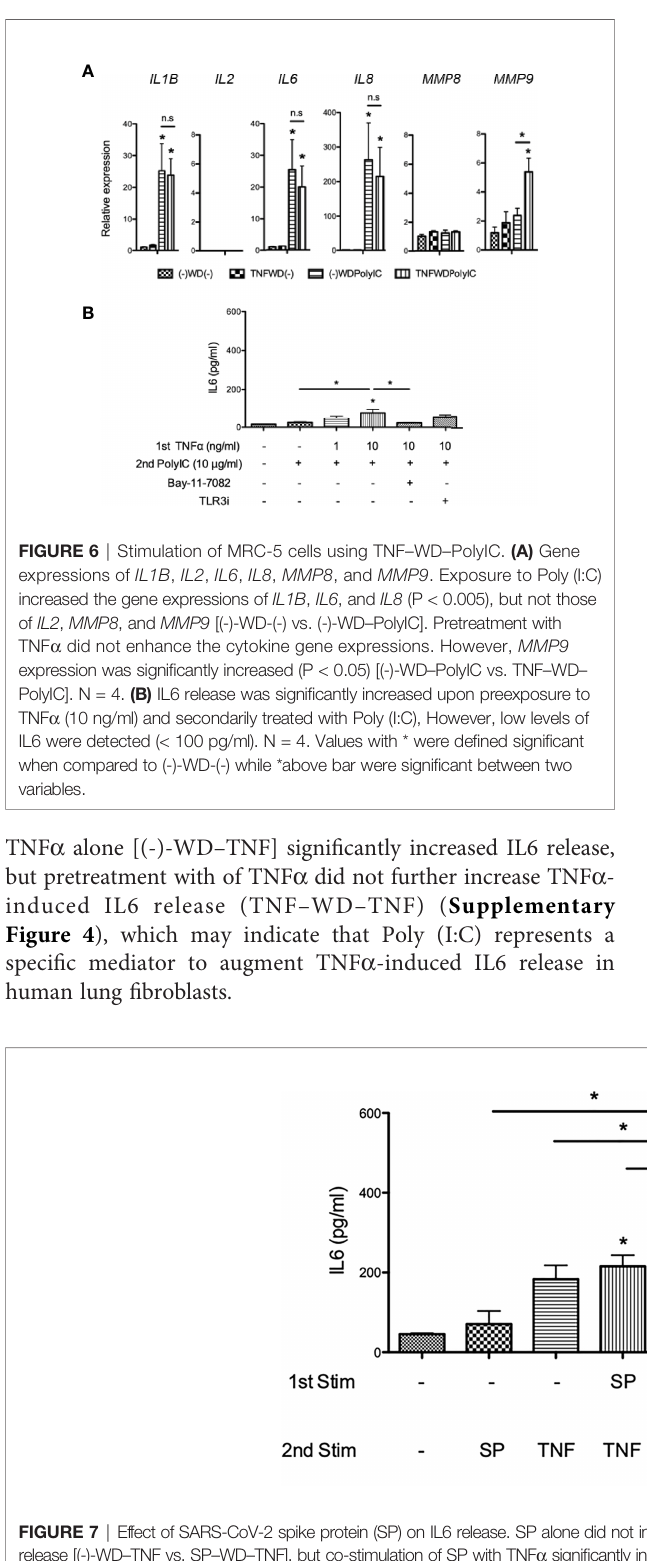
FIGURE 7 | Effect of SARS-CoV-2 spike protein (SP) on IL6 release. SP alone did not increase IL6 release [(-)-WD – SP]. Preexposure to SP did not affect TNF a -induced IL6 release [(-)-WD – TNF vs. SP – WD – TNF], but co-stimulation of SP with TNF a signi fi cantly increased IL6 release [(-)-WD – TNF vs. (-)-WD – SP/TNF] (P < 0.05). Preexposure to Poly (I:C) did not affect the TNF a -induced IL6 release. N = 6. Values with * were de fi ned signi fi cant when compared to (-)-WD-(-) while *above bar were signi fi cant between two variables.